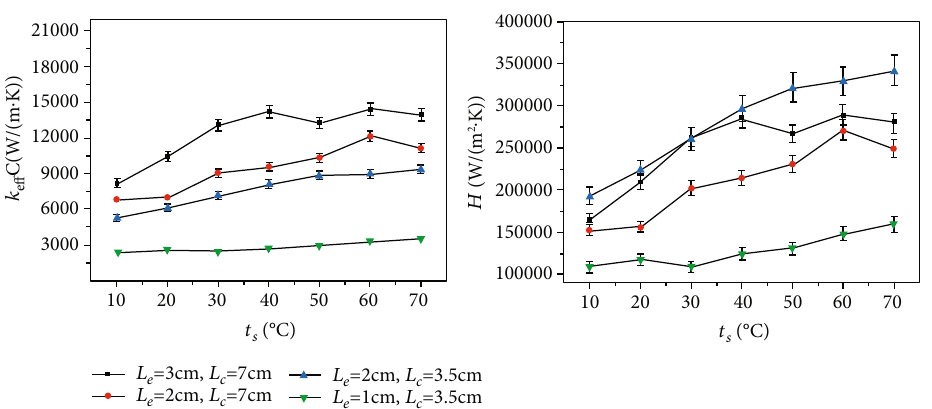
Figure 6: E ff ect of cooling temperature on equivalent thermal conductivity (a) and performance-price coe ffi cient (b) with di ff erent evaporator and condenser lengths.